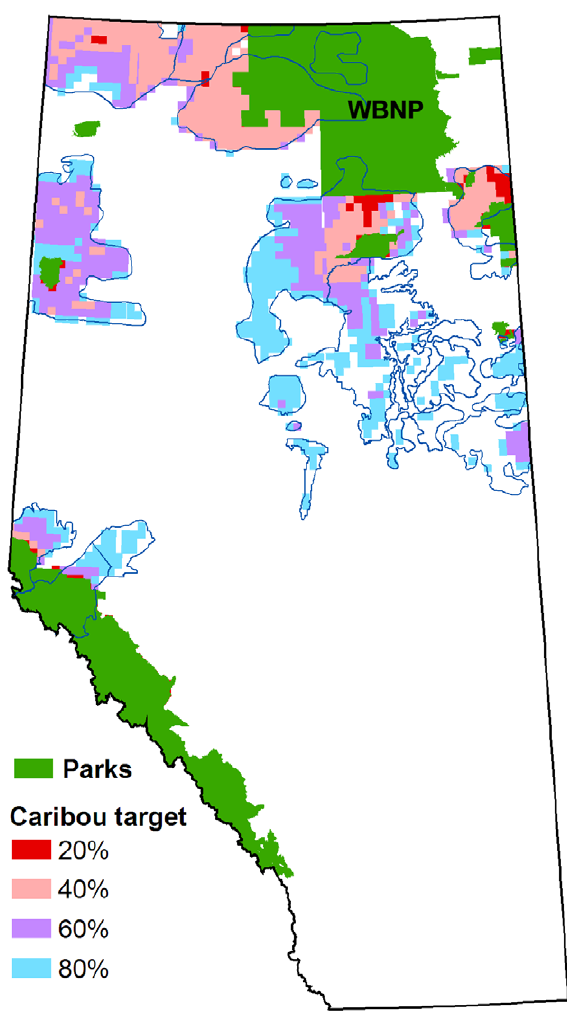
Figure 4. Planning units selected in Scenario 2. Results are shown for four levels of caribou protection target. All models included risk and cost. For clarity, only planning units with a high probability of selection ( . 50%) are shown. Note that most of the units selected at the 20% target lie within existing protected areas and so are hidden from view.